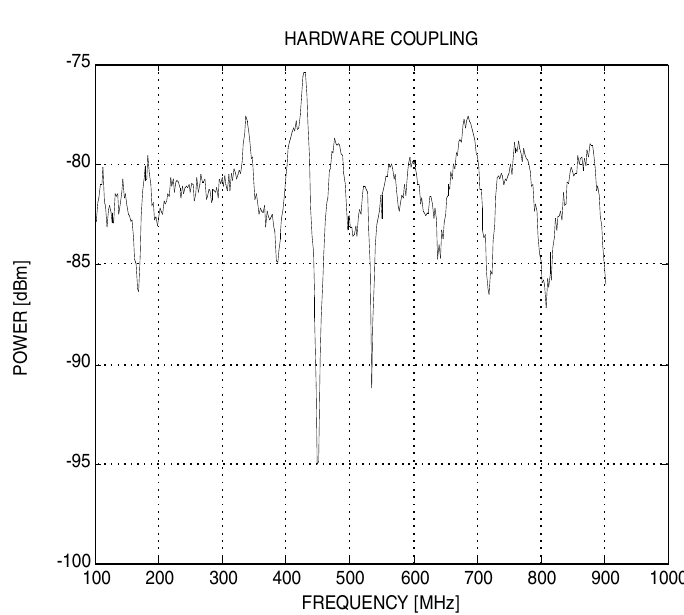
Fig. 6. Electromagnetic coupling internal to the GPR system.